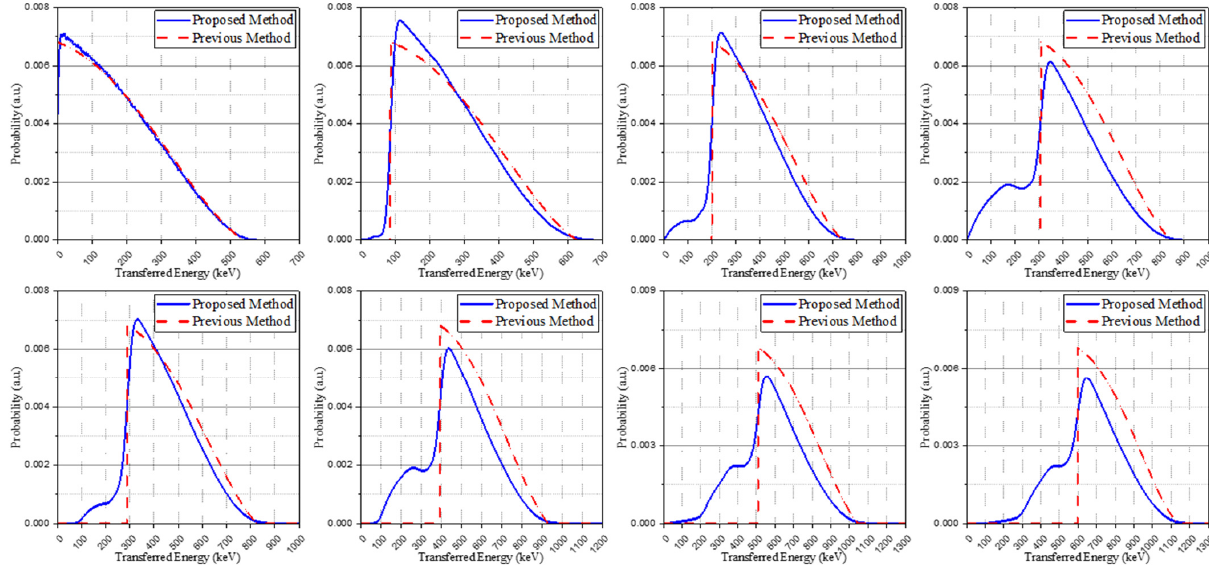
Figure 5. Base spectra of the proposed method (blue solid line) and base spectra of the previous method (red dot line) for configuring the IRL spectrum.